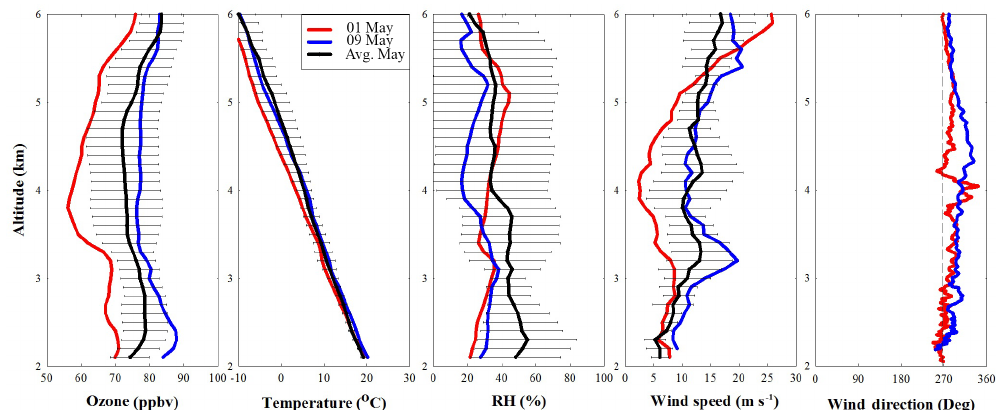
Figure 16. The vertical profiles of ozone, temperature, RH, wind speed and direction over the Nainital region on 1 (red) and 9 (blue) May 2013. The black lines show monthly average (May 2013) vertical profiles with bars representing 1 σ